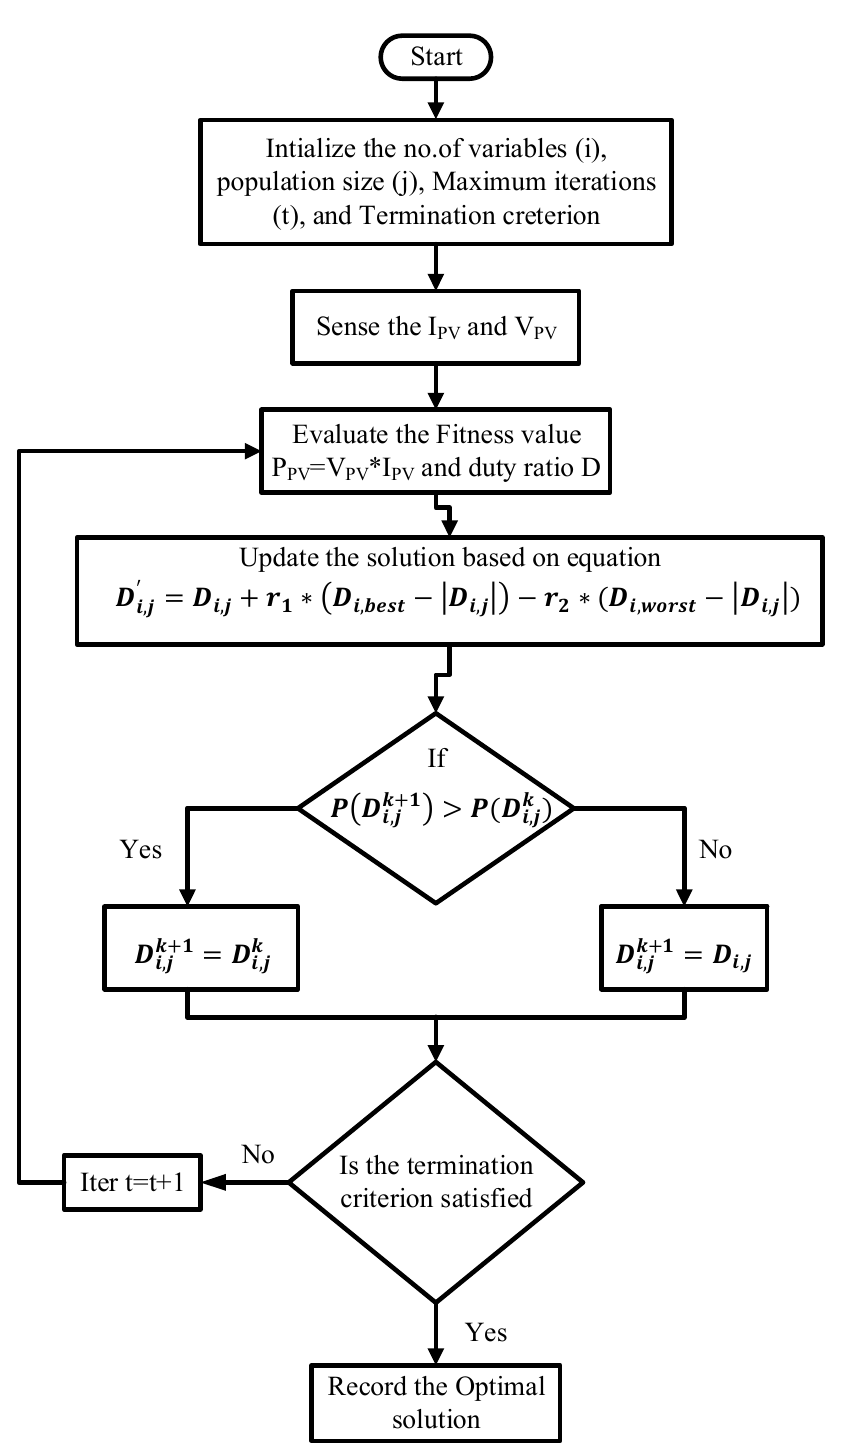
Figure 16. Flow chart of Jaya ‐ based MPPT.